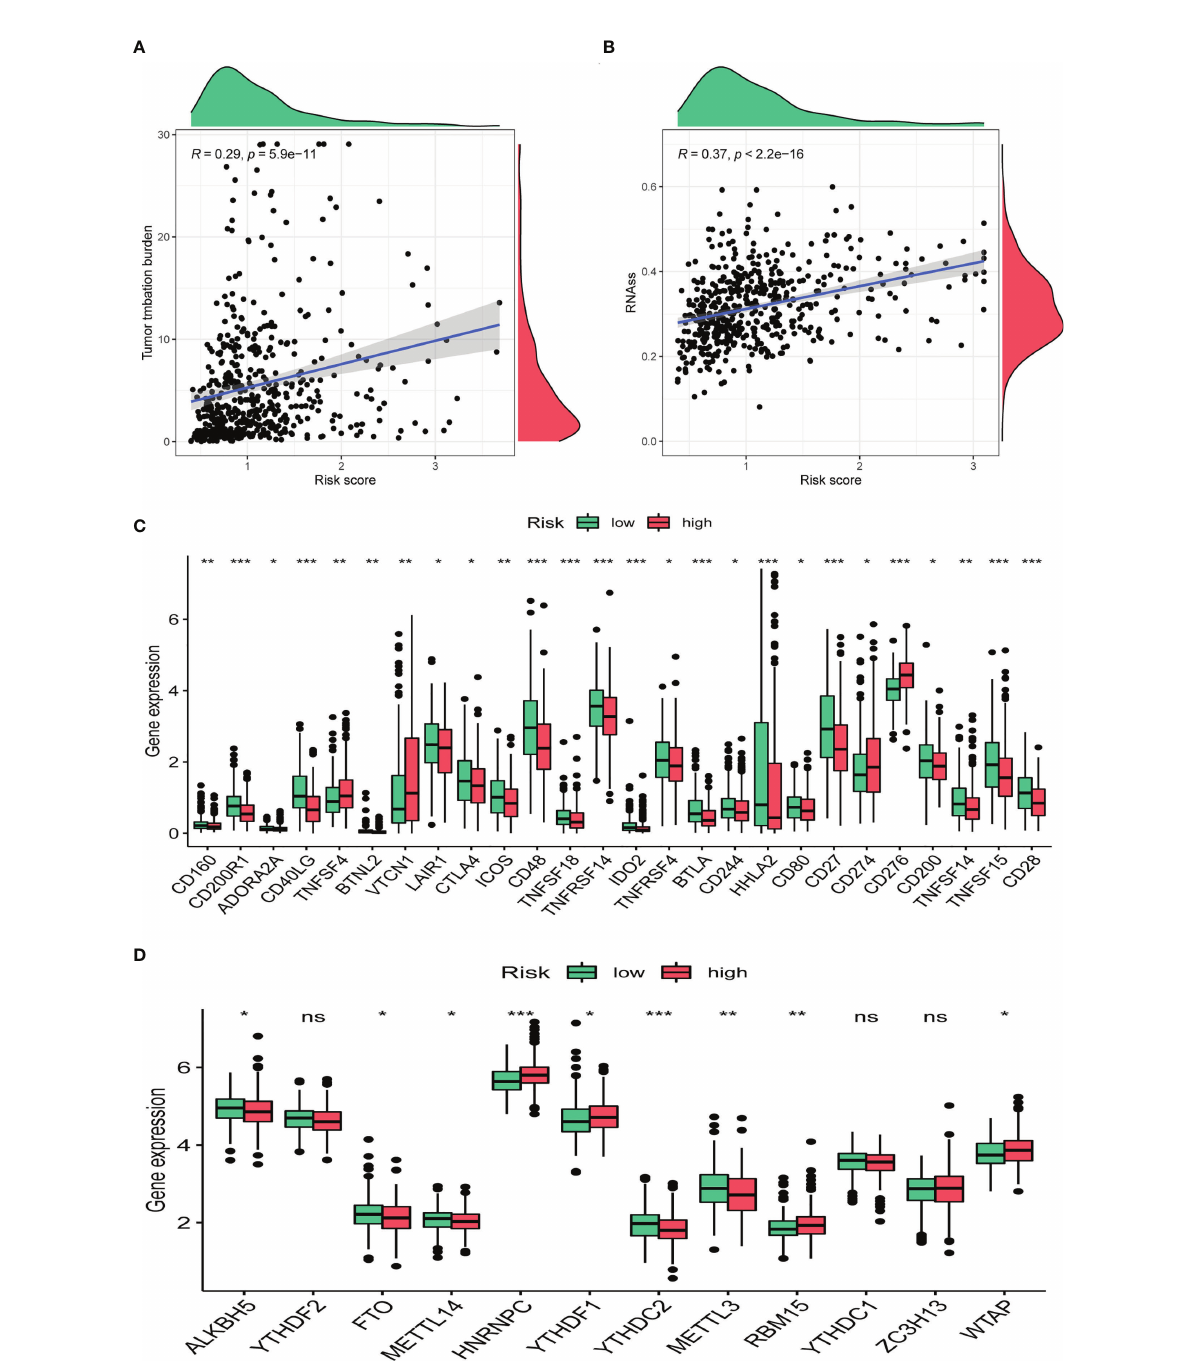
FIGURE 10 Clinical potency analysis. (A) TMB analysis of the CRBS. (B) Cancer stem cells index analysis the CRBS. Comparison of differential expression of (C) immune checkpoints and (D) m6A markers (*p< 0.05; **p< 0.01; ***p< 0.001). ns, no signi fi